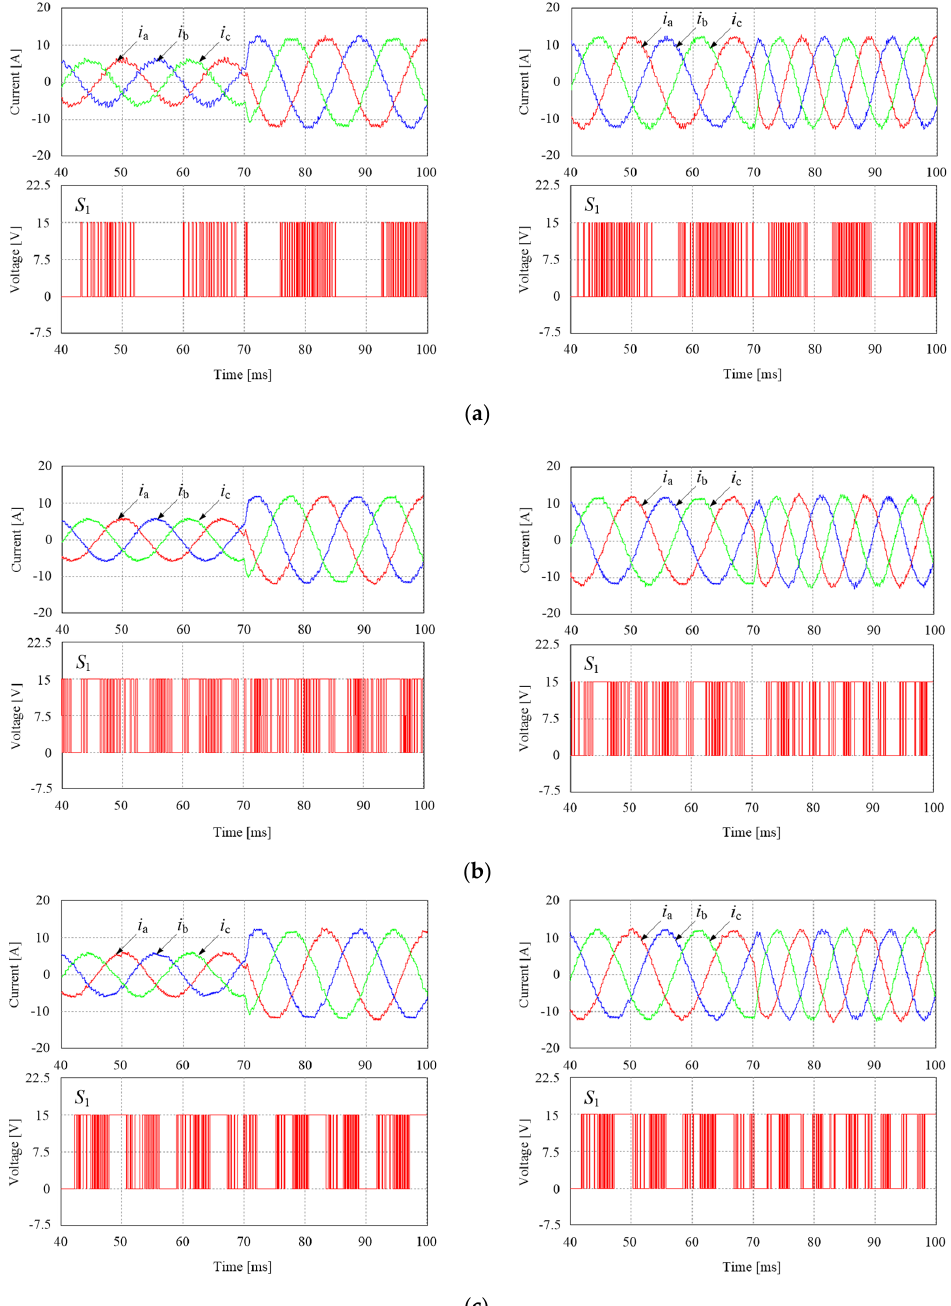
Figure 8. Simulation results of the three-phase output currents ( i a , i b , and i c ) and the a -leg upper switch S 1 for the current magnitude step change from 6 A to 12 A and frequency step change from 60 Hz to 90 Hz (| I *| = 12 A). ( a ) the conventional method using one vector with T s = 125 μ s, ( b ) the conventional method using two vectors with T s = 250 μ s, and ( c ) the proposed method with T s = 250 μ s.